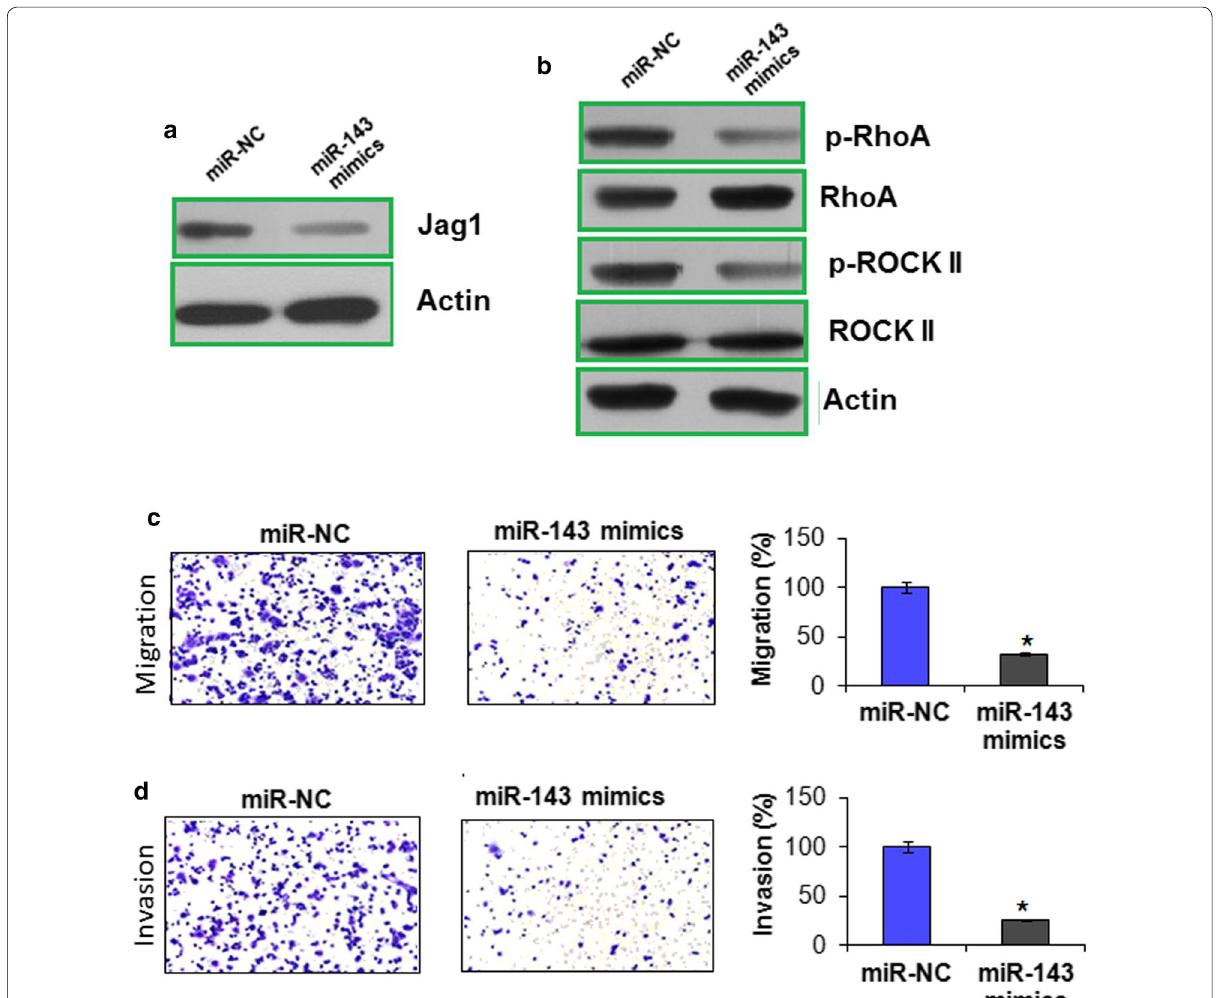
effect of miR-143 overexpression on the Rho- signalling pathway in CAMA-1 cells. c Transwell assay showing cell migration in miR-NC and miR-143 mimics transfected CAMA-1 cells. d Transwell assay showing cell invasion in miR-NC and miR-143 mimics transfected CAMA-1 cells. The experiments were performed in triplicate and expressed as mean SD (*P < ±